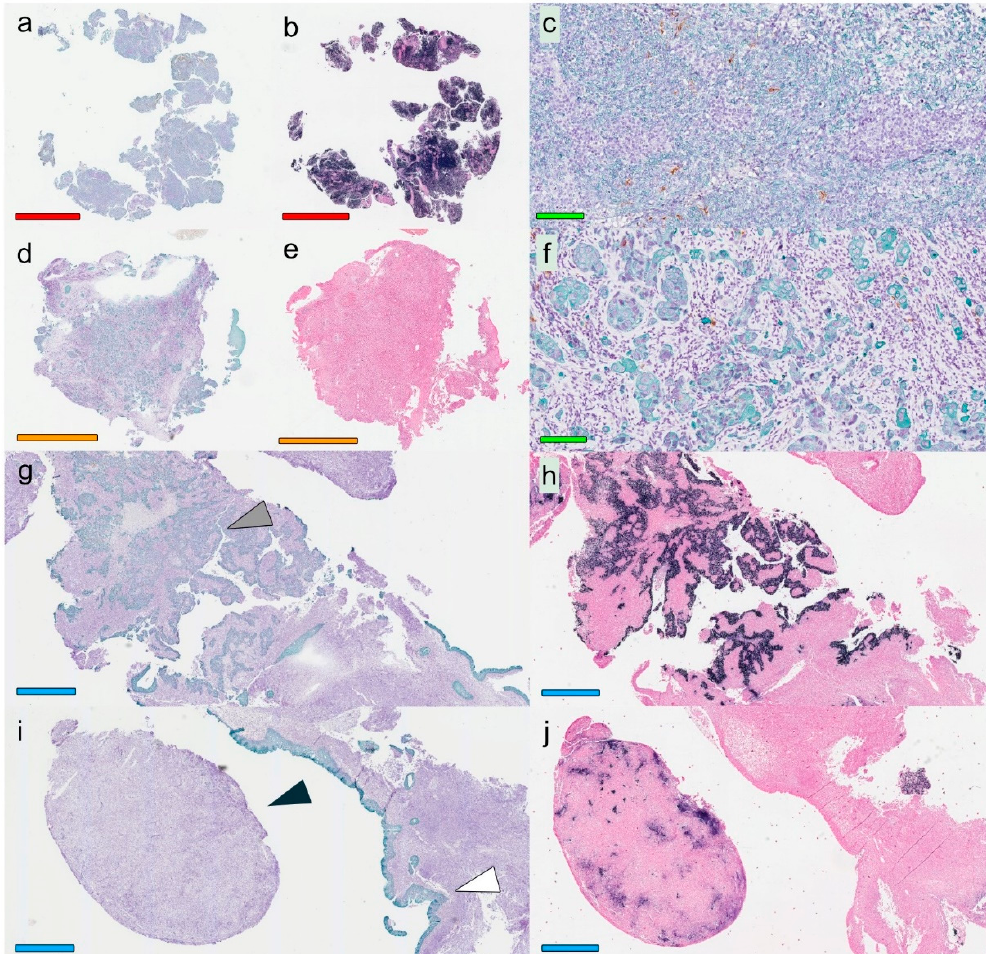
Figure 1. Overall histological view for three selected patients: Patient 1 with EBER-positive NPC ( a – c ), Patient 2 with EBER-negative NPC ( d – f ), and Patient 3 with EBER-positive NPC ( g – j ). A marked heterogeneity was seen between patients ( all panels ) and within a single sample ( g – j ), reflected as varying expression of both CK and EBER. The stainings used were Mayer’s hematoxylin in combination with CK (green) and CD207 (brown) ( a , c , d , f , g , i ) and Red Counterstain II with EBER (black) ( b , e , h , j ). Colored horizontal bars indicate size: red = 3 mm, green = 100 µm, orange = 2 mm, and blue = 900 µm. Arrowheads ( g , i ) denote cancer cells expressing CK and EBER (gray), cancer cells with loss of CK (black), and normal CK-staining of epithelium as comparison (white). Abbreviations: EBER = Epstein–Barr virus encoded small RNAs, NPC = nasopharyngeal cancer, and CK = cytokeratin. 2.3. Immune Phenotypes: “Inflamed”, “Excluded”, and “Deserted” Immune phenotypes of the NPC lesions were estimated based on qualitative assessment of